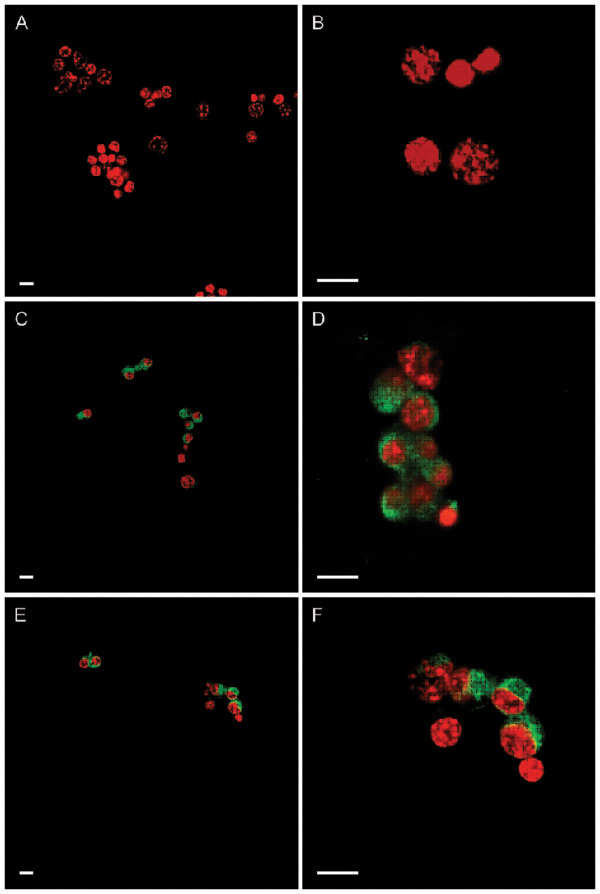
Expression of GM-CSF α and β receptors in bovine cumulus cells. Confocal microscopy analysis was performed using anti-GM-CSFrα and anti-GM-CSFrβ antibodies. A, B: Specimen incubated without the first (primary) antibody showed no signal. C, D: GM-CSFrα subunit (green). E, F: GM-CSFrβ subunit (green). Cell nuclei were stained using propidum iodide (red). Scale bar = 10 μm.